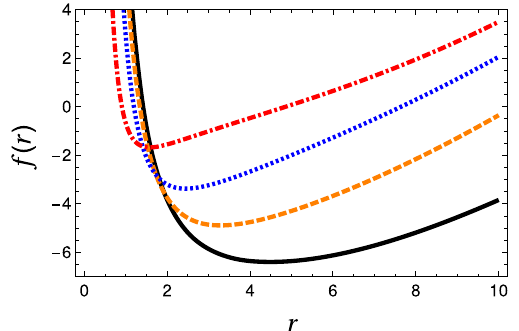
Fig. 2 Radial dependence of the lapse function f ( r ) for (cid:8) 0 = 5, G 0 = 1, M 0 = 1, and J 0 = 1. The different curves correspond to the classical case (cid:12) = 0 solid black line, (cid:12) = 0 . 05 dashed orange line, (cid:12) = 0 . 2 dotted blue line, and (cid:12) = 1 dot-dashed red